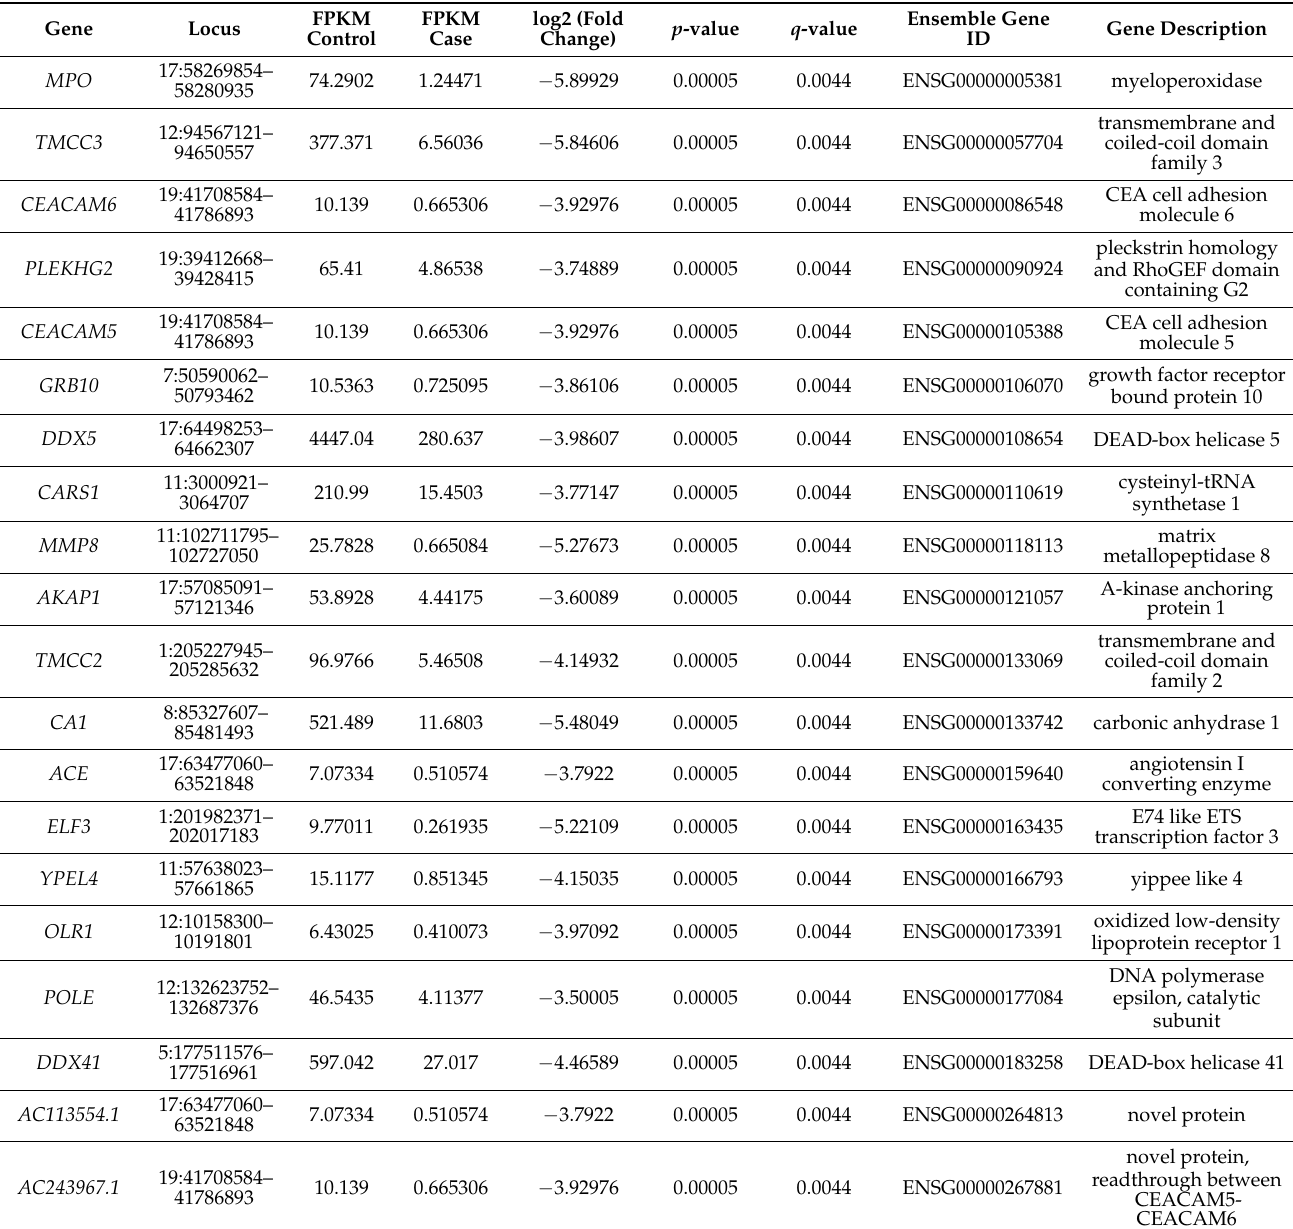
Table 4. List of the top 20 downregulated genes with foldchange ≤− 3.5, a p -value ≤ 0.00005 and a q -value ≤